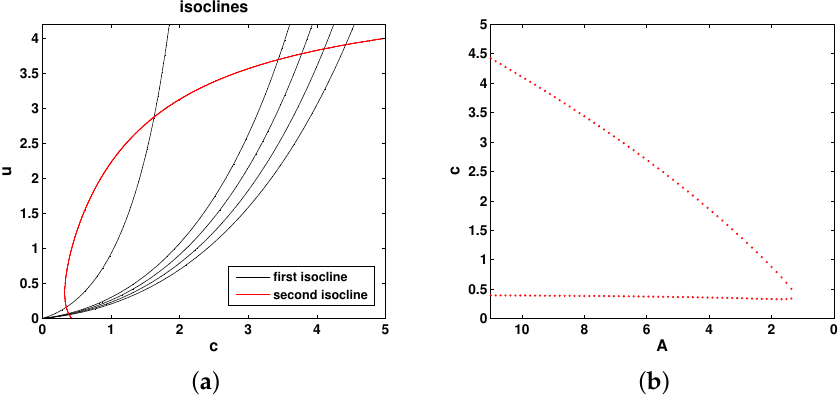
Figure 5. ( a ) The (null-)isoclines of the oxygen-phytoplankton system for Model 4. Black curves show the oxygen isocline ( u I ) for A = 3.5,8,9,10 and 11 (from left to right, respectively), and the red curve shows the phytoplankton isocline ( c II ). ( b ) Positive steady states of Equations (14) and (15) shown as functions of A . Here c 2 = 0.5, other parameters are the same as in Figure